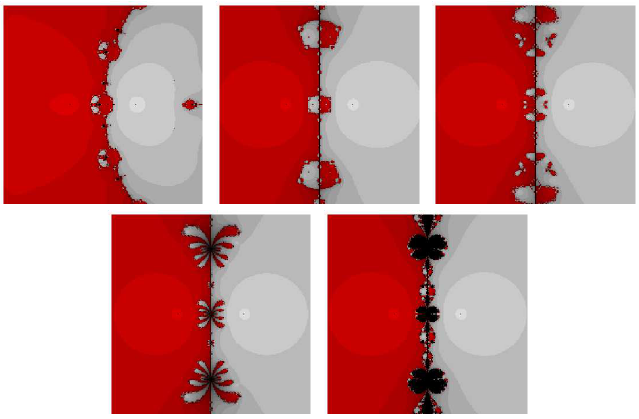
Figure 8. The basins of attraction for OM 4 , LM 4 , SSM 4 , ZM 4 and SM 4 , from left to right and top to bottom, respectively in Problem 5.